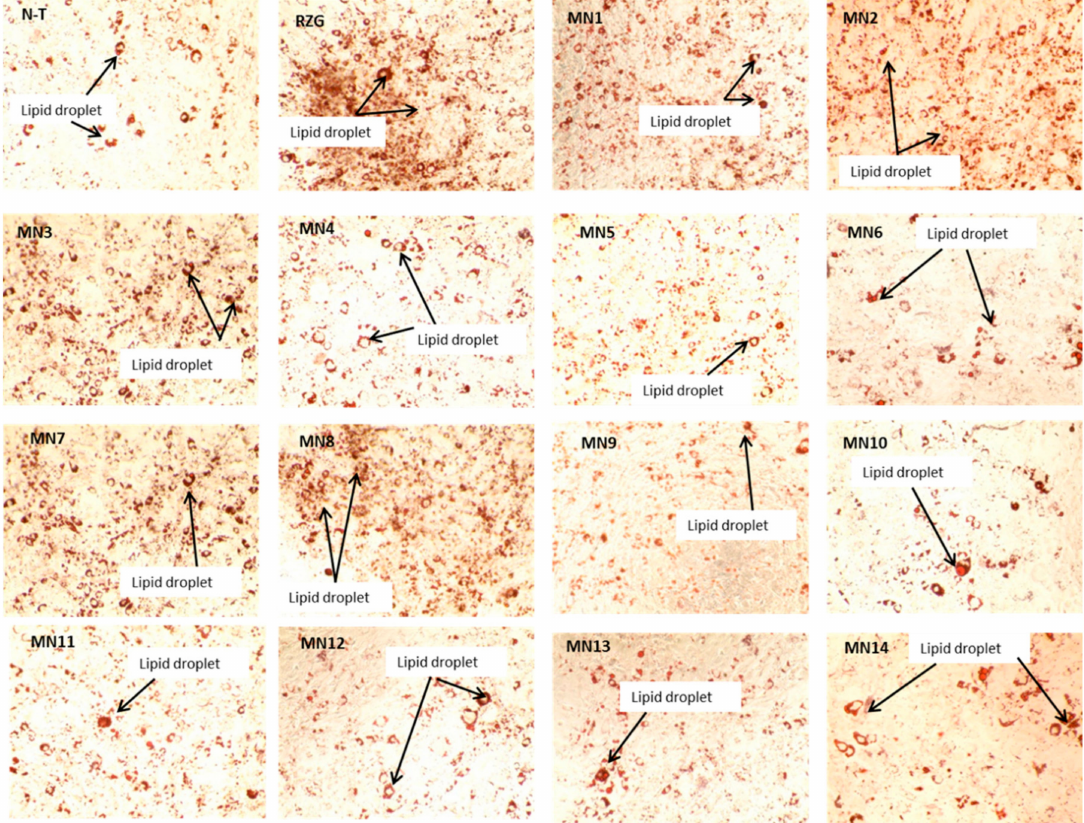
Figure 7. Lipid droplets formations of 3T3-L1 adipocyte cells stained with Oil red O. Magnification 40 × . (NT: non-treated, MN1: wogonin, MN2: methyl ether of wogonin, MN3: acetate of wogonin, MN4: techtochrysin, MN5: 8-hydroxy-7-methoxyflavone, MN6: chrysin, MN7: norwogonin, MN8: acetate of norwogonin, MN9: isoscutellarein, MN10: hypolaetin, MN11: kaempferol, MN12: quercetin, MN13: (+)-catechin and MN14: